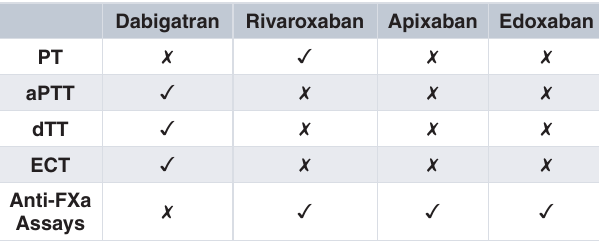
Table 4. Assays to measure the anticoagulant activity or plasma levels of the direct oral